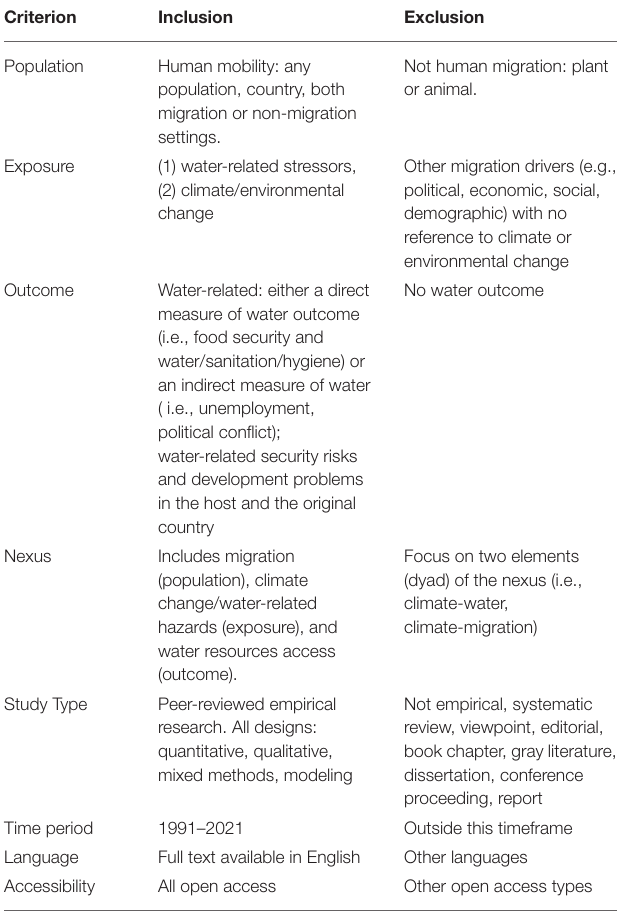
TABLE 2 | Inclusion and exclusion